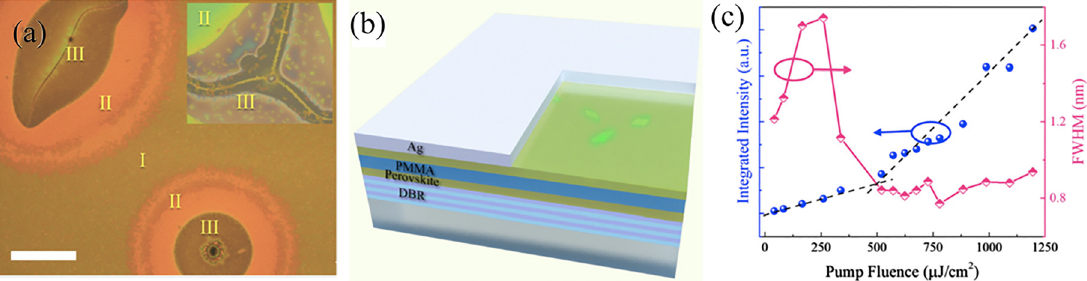
Figure 6: (a) Optical microscopy image of the segregated quasi-2D perovskites. (b) Schematic diagram of DBR cavity structure. (c) Pumping fluence-dependent emission intensity and FWHM for the segregated quasi-2D perovskites. Reproduced with permission [39]. © 2019 AIP